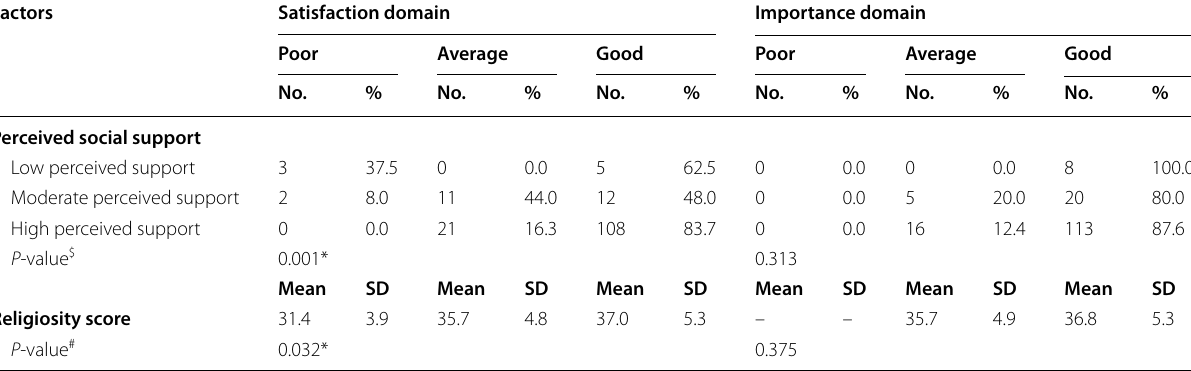
Table 6 Relation between quality of life, perceived social support, and religiosity among patients on haemodialysis, Saudi